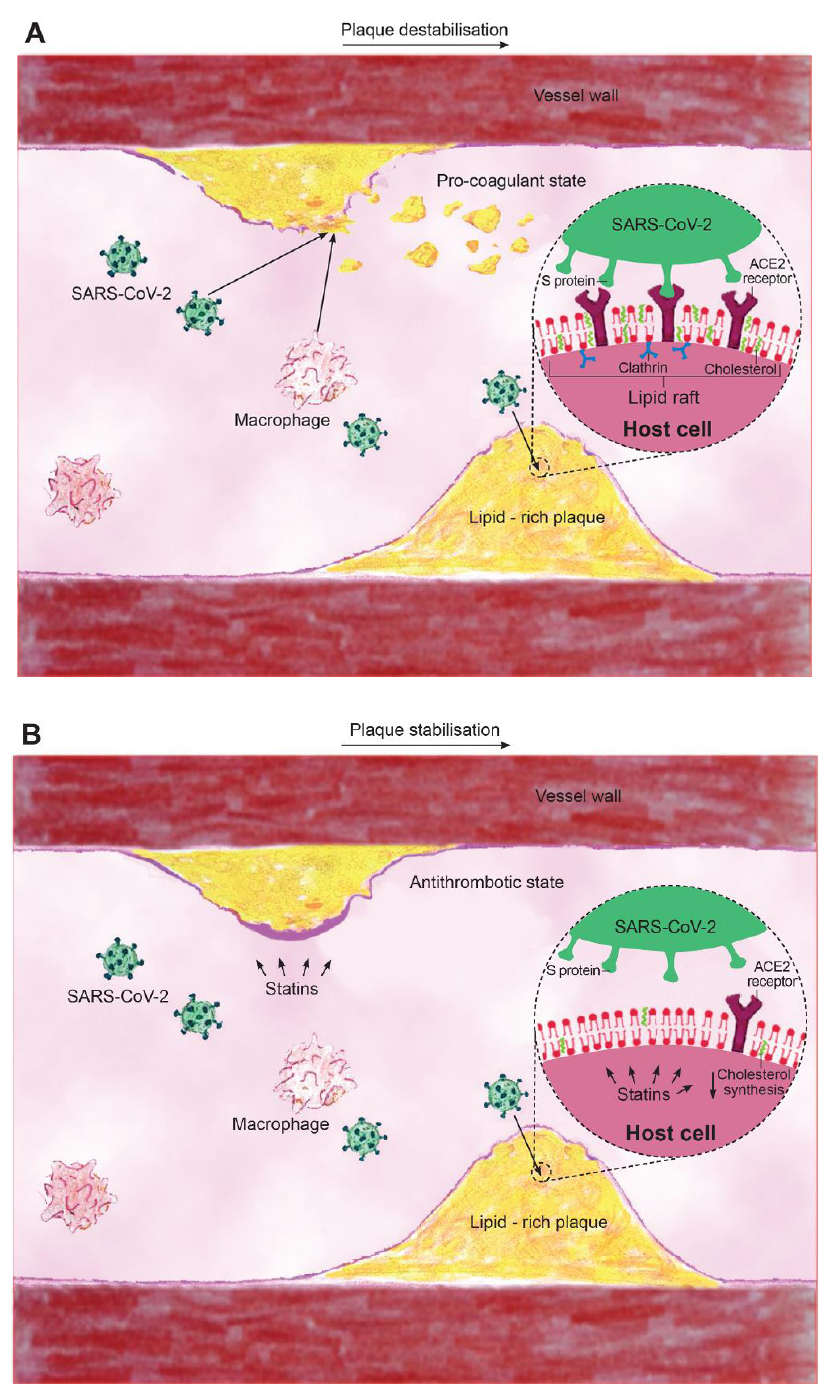
Figure 1. Proposed mechanism of the role of cholesterol and statins in severe acute respiratory syndrome coronavirus 2 (SARS-CoV-2) infection. ( A ) Lipid rafts rich in cholesterol serve as docking sites for angiotensin-converting enzyme 2 (ACE2) receptors and viral attachment via the S protein of SARS-CoV-2, which is then taken into the cells by clathrin. In addition, acute infection with SARS-COV-2 and macrophages via paracrine factors can lead to plaque instability and embolization causing occlusion of distal microvasculature. ( B ) Statins disrupt lipid rafts and viral binding; reduce cholesterol; and have plaque stabilising, antithrombotic, and anti-inflammatory properties. The role of cholesterol in viral entry has been studied for several coronaviruses including SARS-CoV [14], murine coronavirus [15], porcine deltacoronavirus [12], and infectious